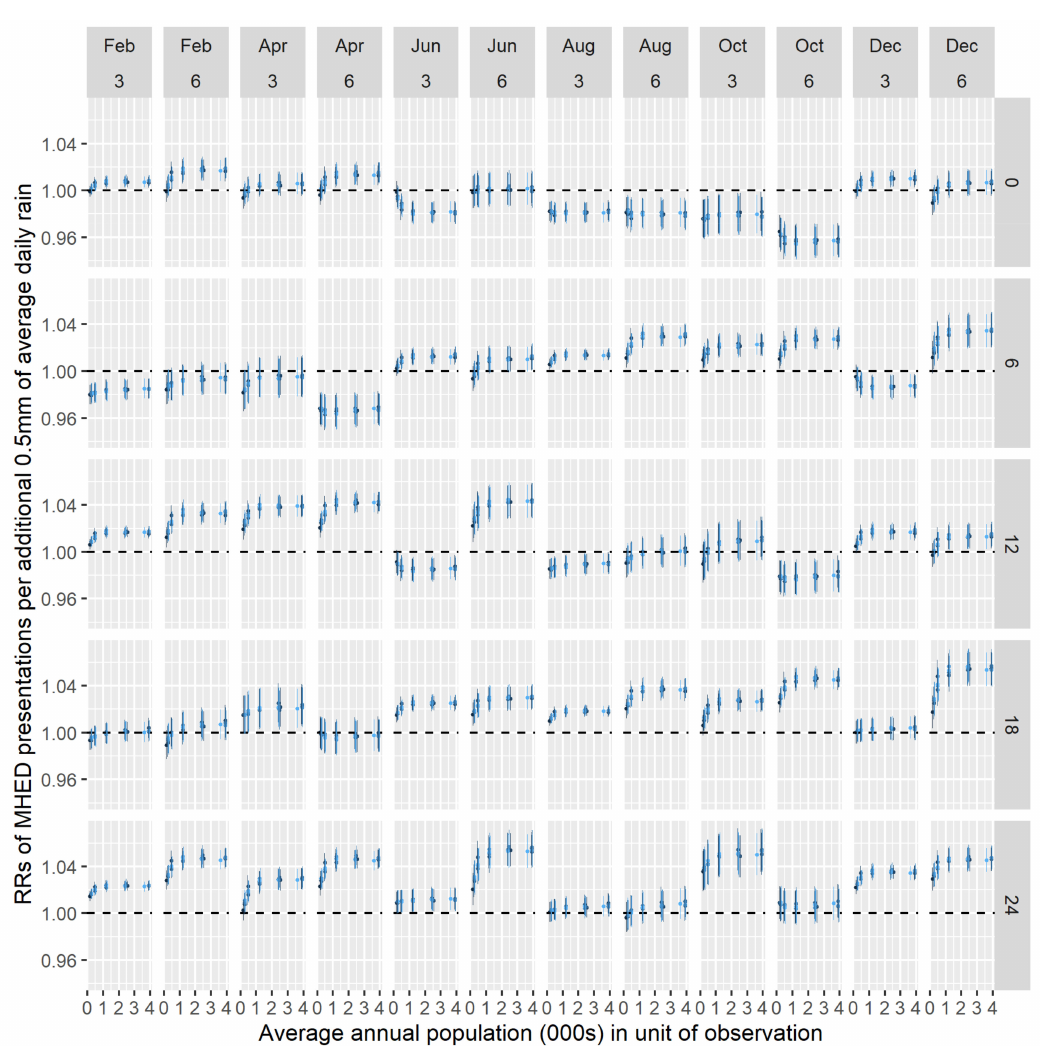
Figure 6. Rate ratios (RRs) ( dots ) and 95% credible intervals ( lines ) from models fitted to different spatial and temporal data preparations (females). Different shades of blue indicate estimates for different spatial zonations at each scale, in each panel. Black dots and lines indicate results from statistical area level 1 (SA1)-level analyses. MHED: mental health-related emergency